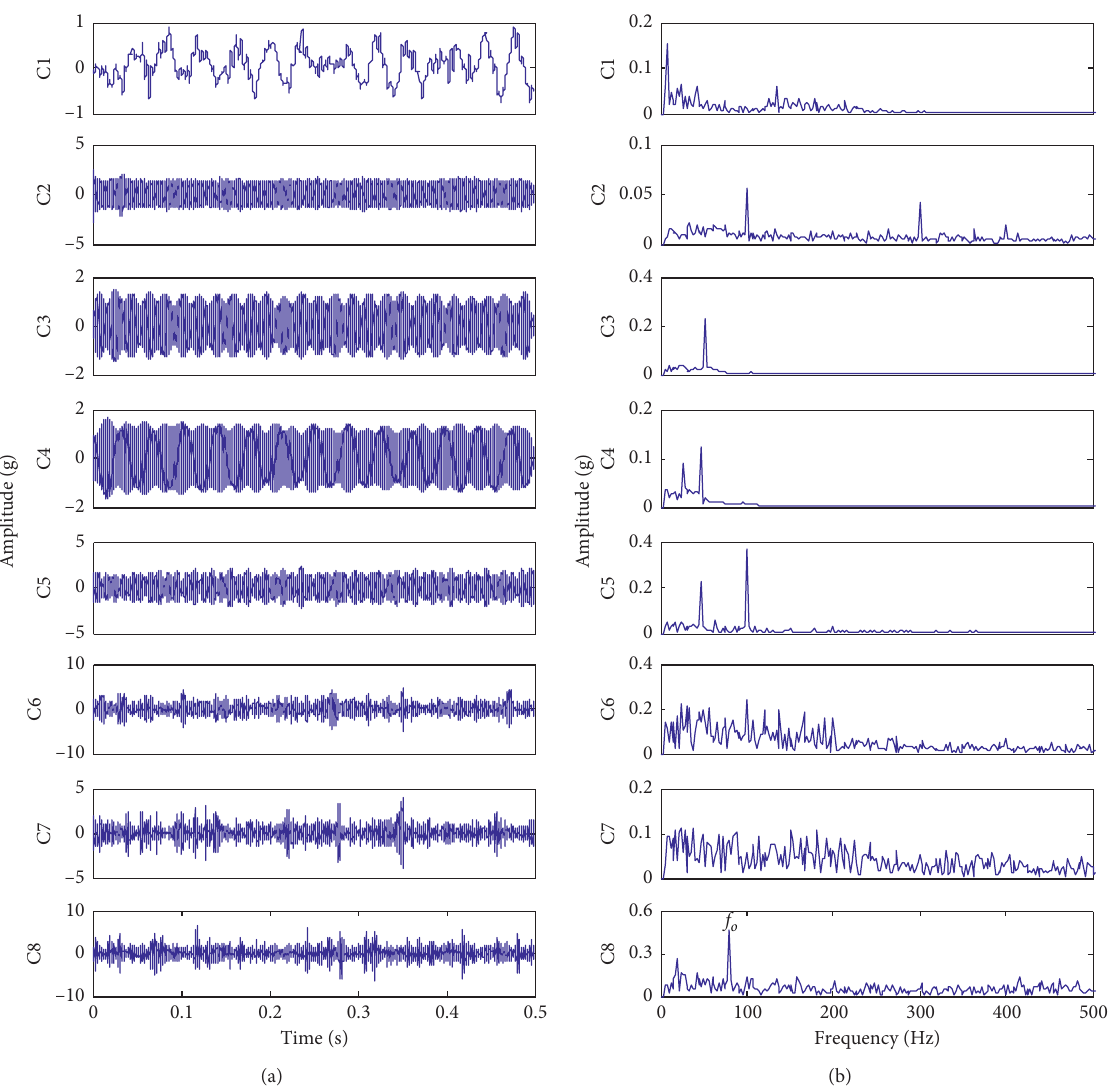
Figure 26: Comparison results of engineering signal by the EWT method: (a) the waveforms of separated components; (b) the envelope spectra of separated